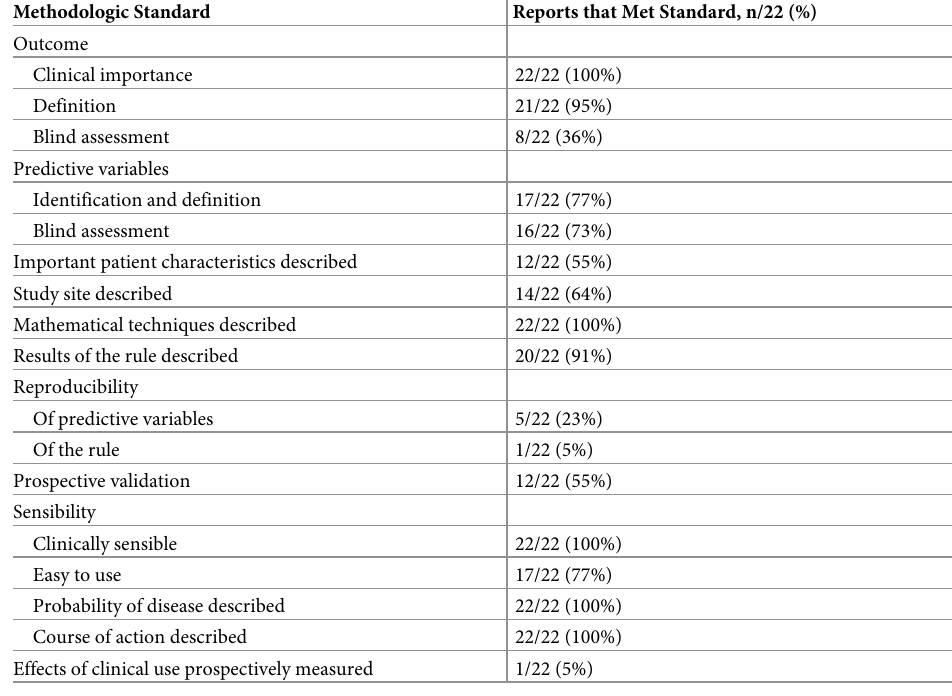
Table 2. Methodological standards applied to calculator tool primary reference (total: 22 studies).